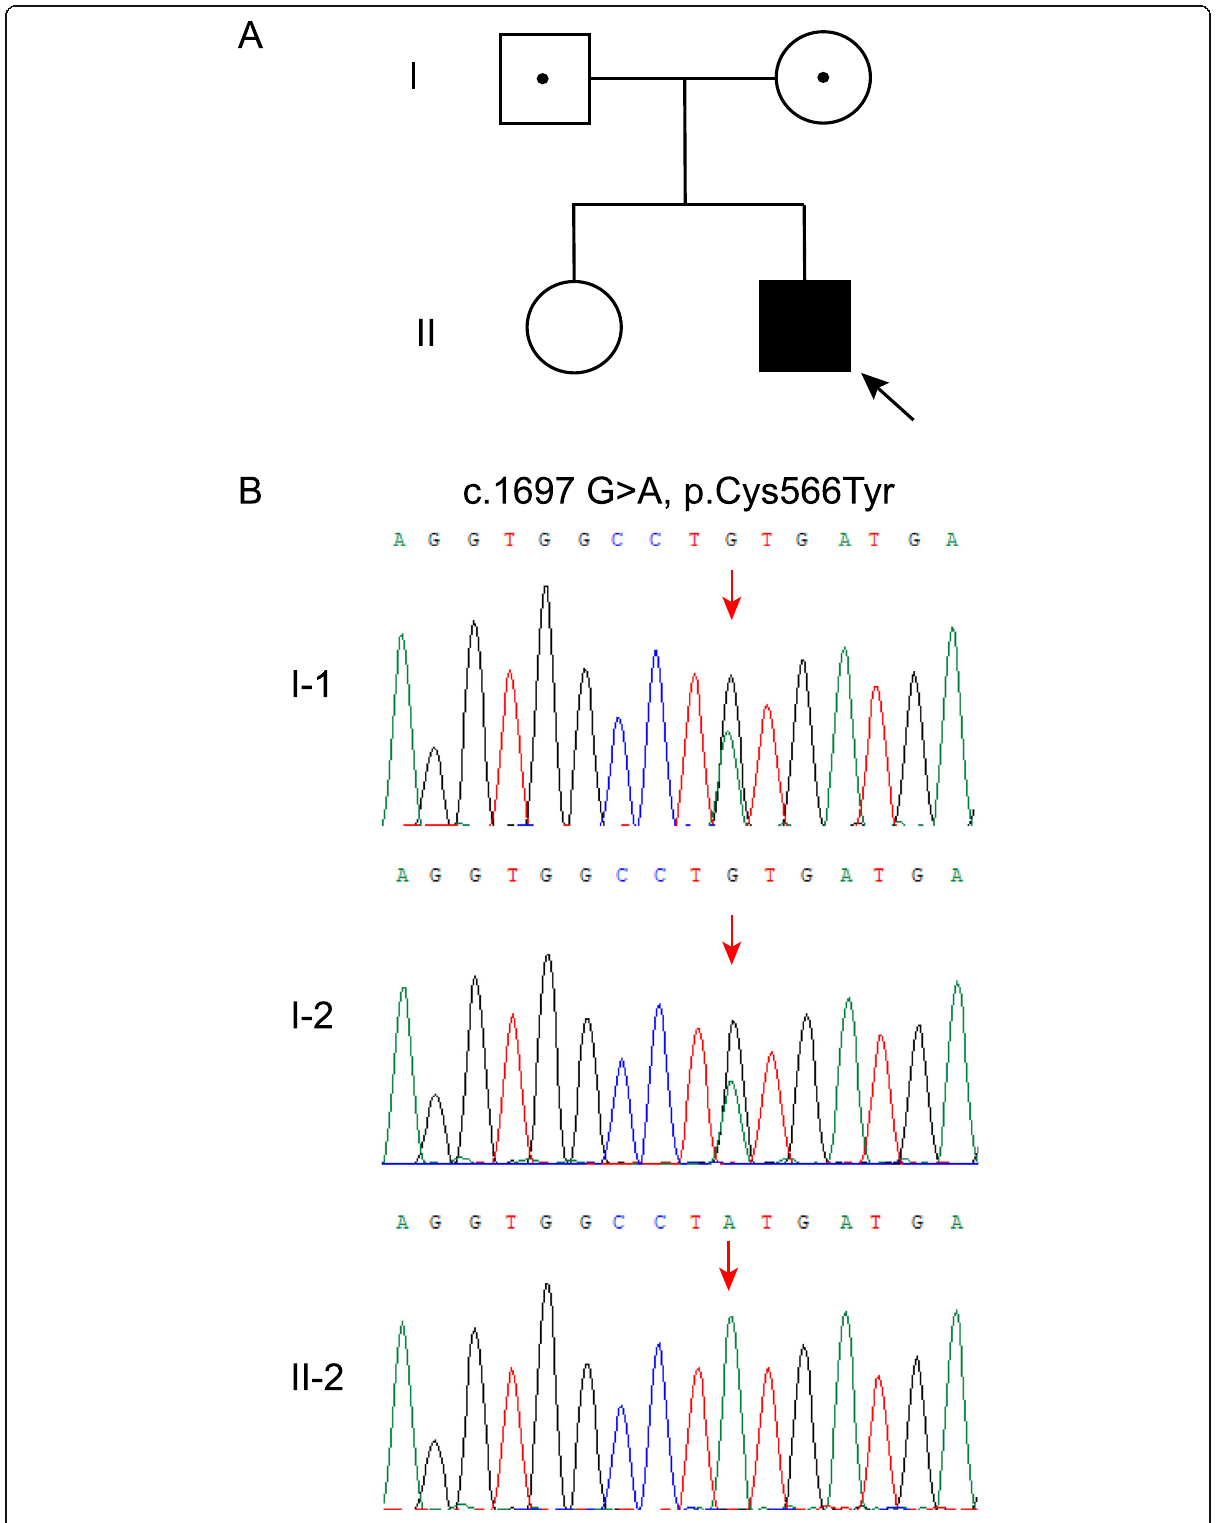
Fig. 1 Pedigree and molecular analysis of the family with kEDS-PLOD1. a Pedigree of the family of kEDS of Chinese origin. b A homozygous mutation of PLOD1 (c.1697 G>A) in patient (II-2) is a novel missense mutation (p.C566Y). His parents (I-1 and I-2) were heterozygous carriers of corresponding mutation. Black symbols present affected individuals, white symbols with black dots present carriers of the